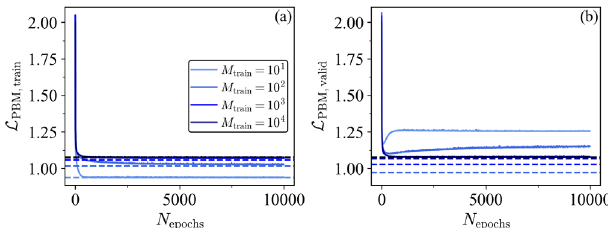
p Þ and (b) the correspond- 14. (a) Mean prediction ˆ y PBM ð p Þ of PBM for the Ising model ( L ¼ 60 ) using ing indicator I PBM ð NNs obtained after long training for various regularization strengths λ l 2 [cf. Eq. (B3)]. The tuning parameter ranges from 10 with Δ p ¼ 0 . 05 . The critical value of the p 1 ¼ 0 . 05 to p K ¼ k T =J is highlighted in red. The optimal tuning parameter p c ¼ B c predictions and indicator are highlighted in black. Each NN has a single hidden layer with 2048 nodes and is trained for 10 000 epochs with a learning rate of